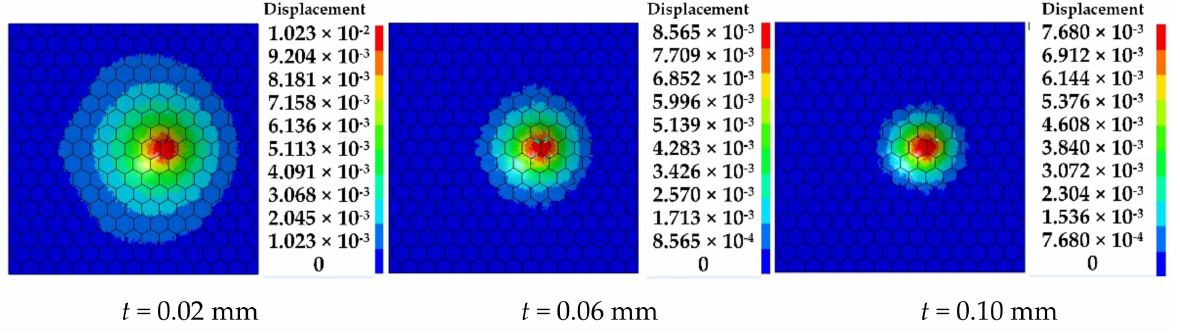
Figure 4. The deformation contours of the sandwich after an oblique impact, this study.